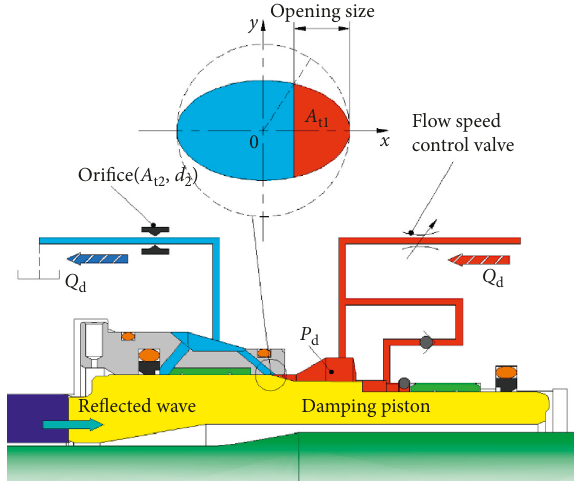
Figure 3: The oil circuit diagram of the double damping